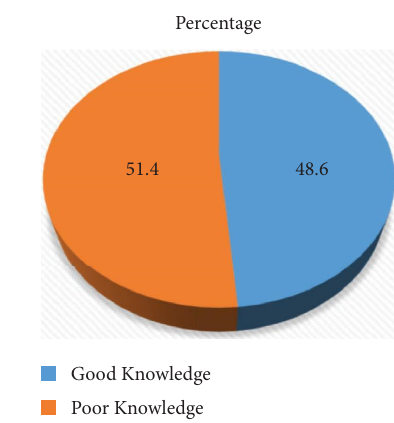
Figure 1: Level of knowledge regarding mechanical ventilators among nurses working in the ICU of selected government hospitals in Addis Ababa, Ethiopia, 2021 ( N �